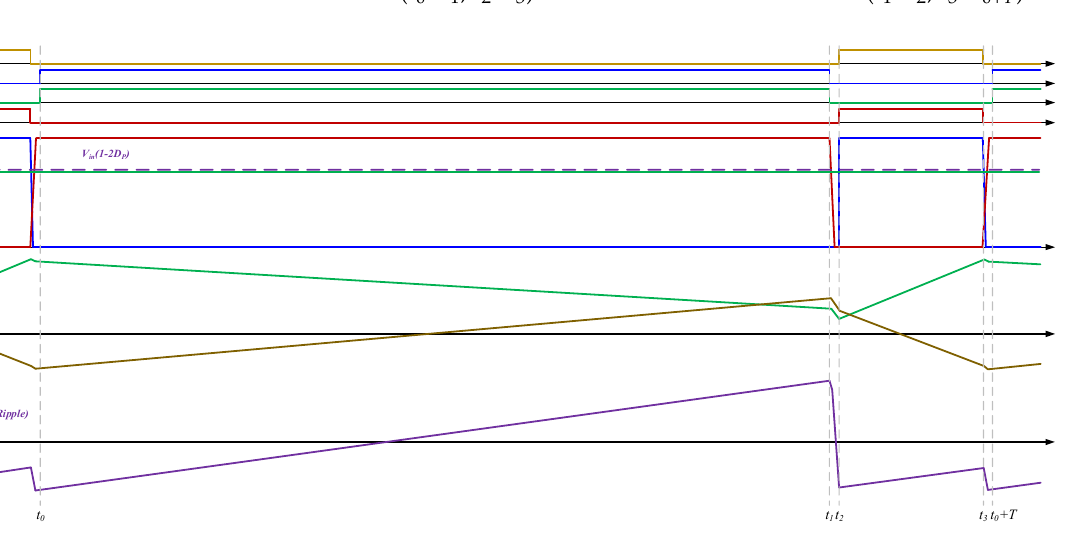
V P and V S node voltage waveforms v P and v S , which are redrawn as Figure 16.